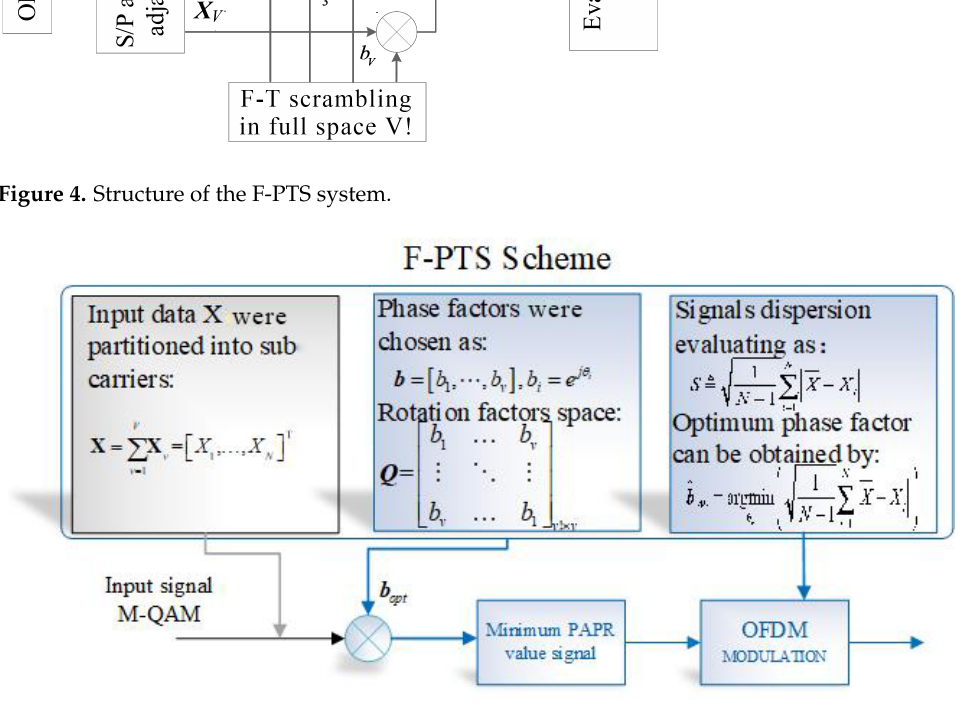
Figure 5. Algorithm of the F-PTS